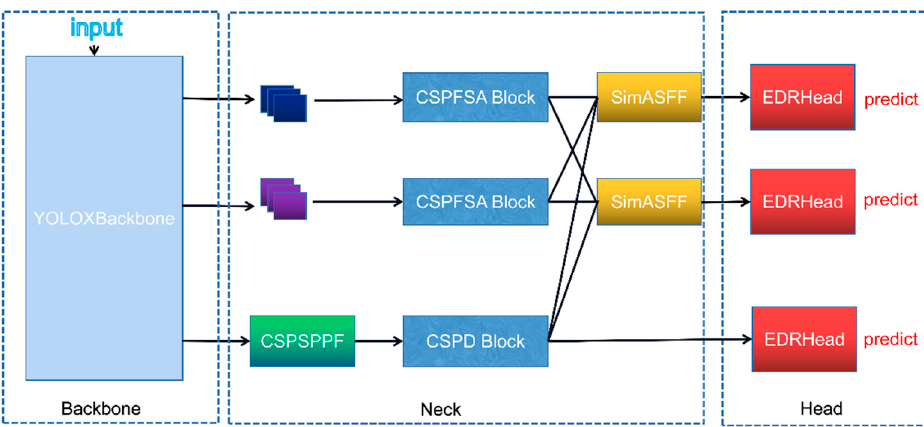
Figure 1. Diagram of the network structure of the EYOLOX detector.